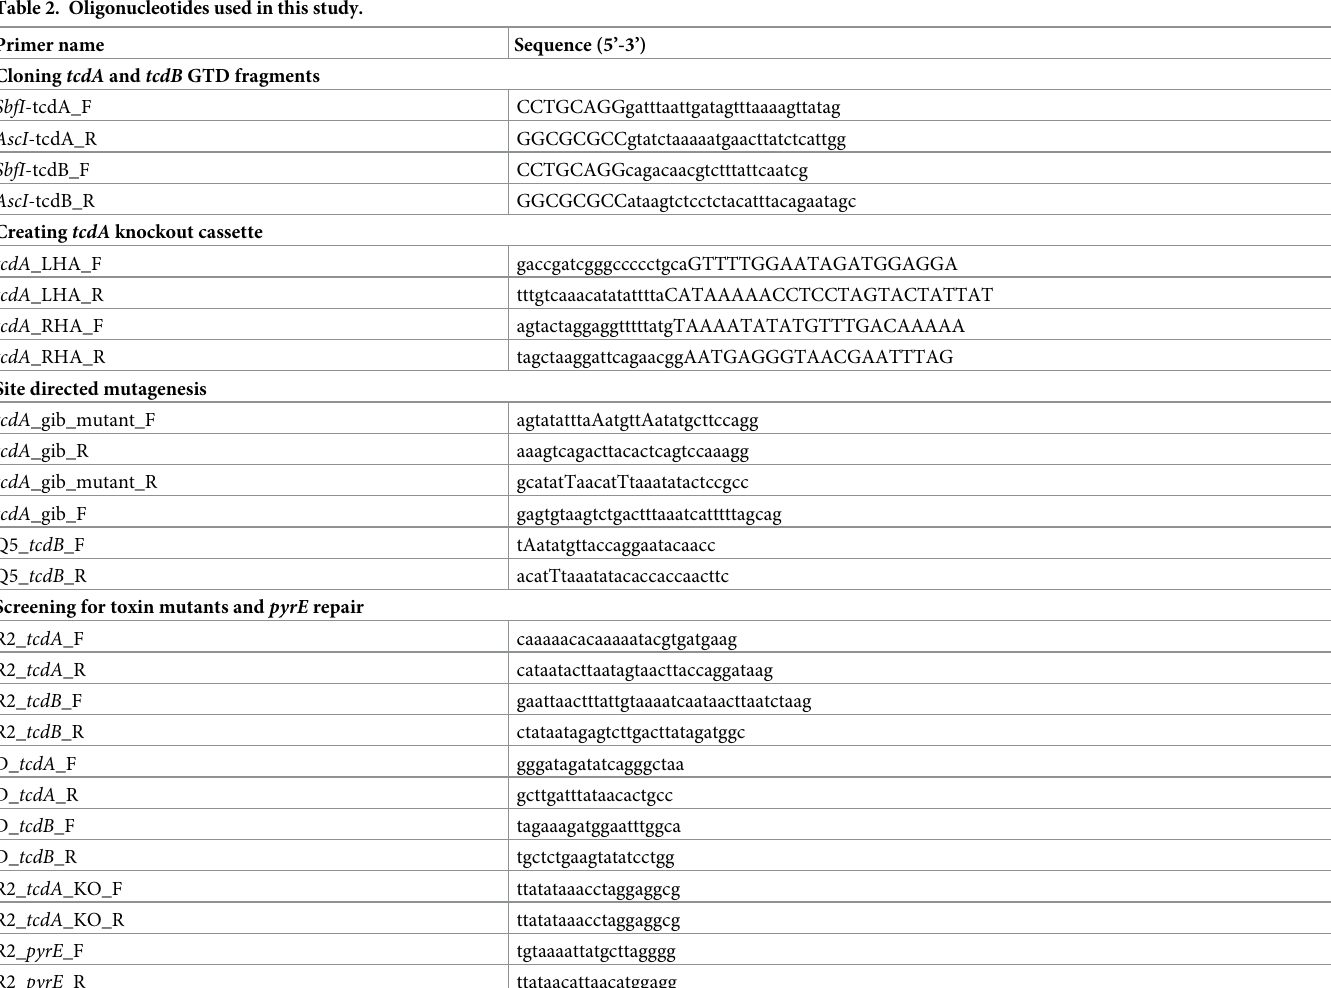
� Uppercase letters denote overhangs for restriction sites or for Gibson assembly. Upper case letters represent single nucleotide mutations for introduction into tcdA or tcdB